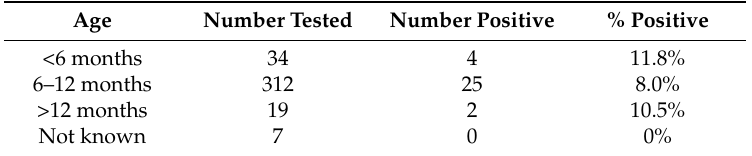
Table 1. Porcine reproductive and respiratory syndrome virus (PRRSV) polymerase chain reaction (PCR) results for 372 tonsil samples from PRRS seropositive or inconclusive animals, by